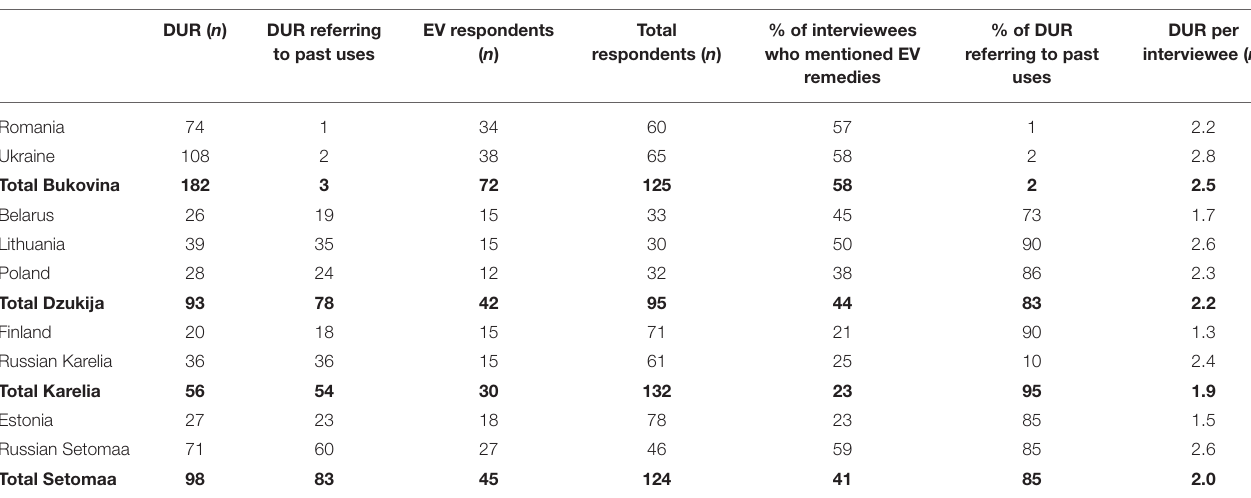
TABLE 3 | Ethnoveterinary knowledge by region.